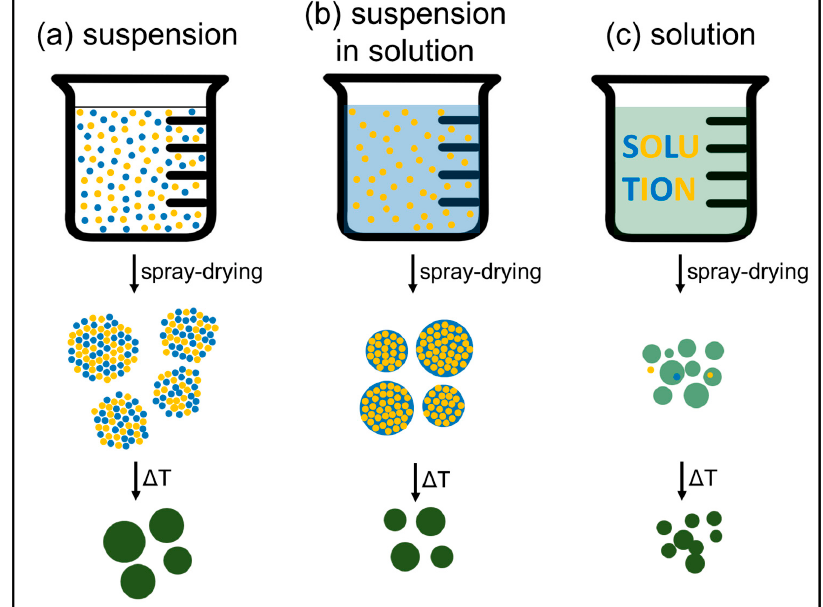
Figure 3. Spray-drying of ( a ) a suspension of solid particles (blue and yellow) dispersed in a non-solvent (transparent); ( b ) a suspension of solid particles (yellow) in a solution (light blue); ( c ) a solution (light green) of soluble precursors. All schematics consider the case where the spray-dried precursor is further transformed into the final phase (dark green) by heat treatment.